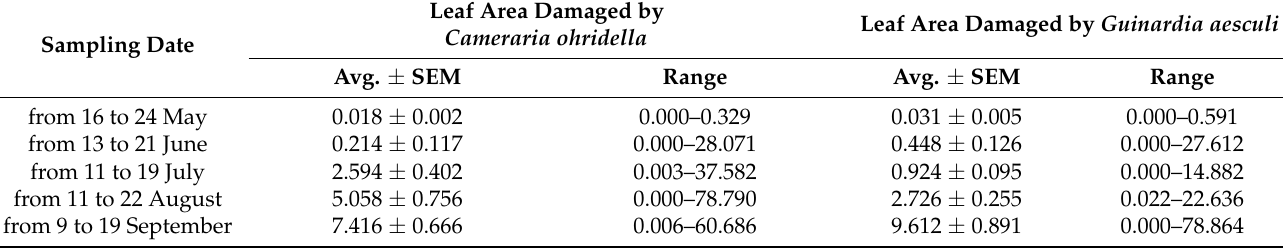
Table 2. The average percentage of horse chestnut leaf area damaged by Cameraria ohridella and Guignardia aesculi during vegetation season. Pooled data from all sampling sites across city (average ± SEM, n =